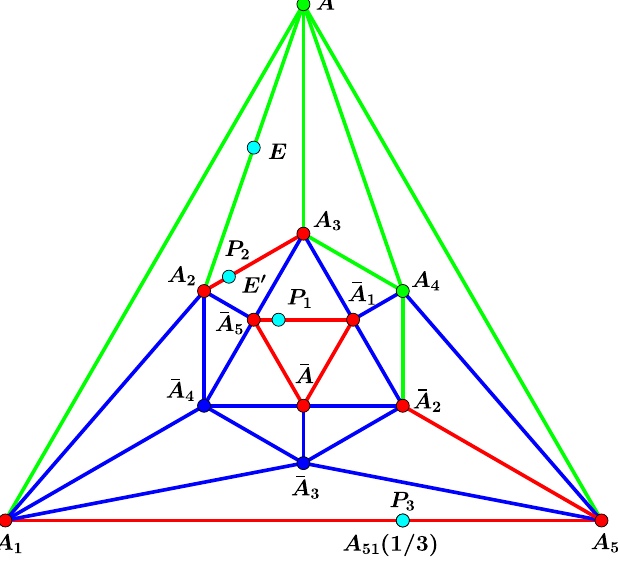
Figure 7. The projection E (cid:48) of evader E ∈ S = AA 1 ∪ AA 2 ∪ AA 3 ∪ AA 4 ∪ AA 5